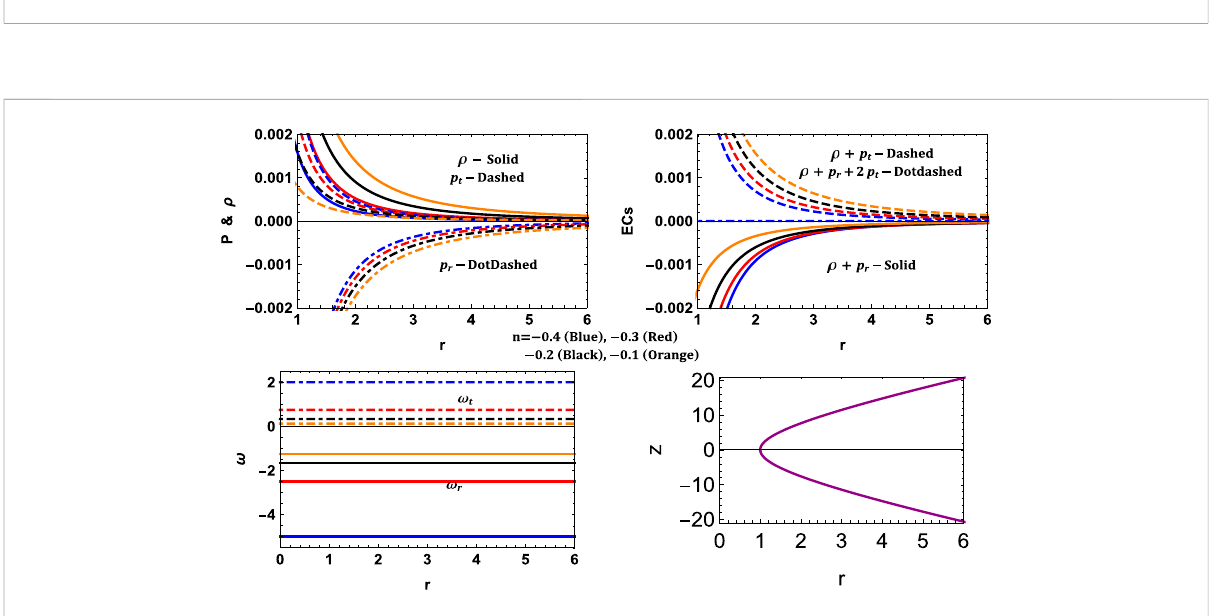
FIGURE 10 Variation of energy conditions and embedding surface for model IV with H = 0.2, λ =